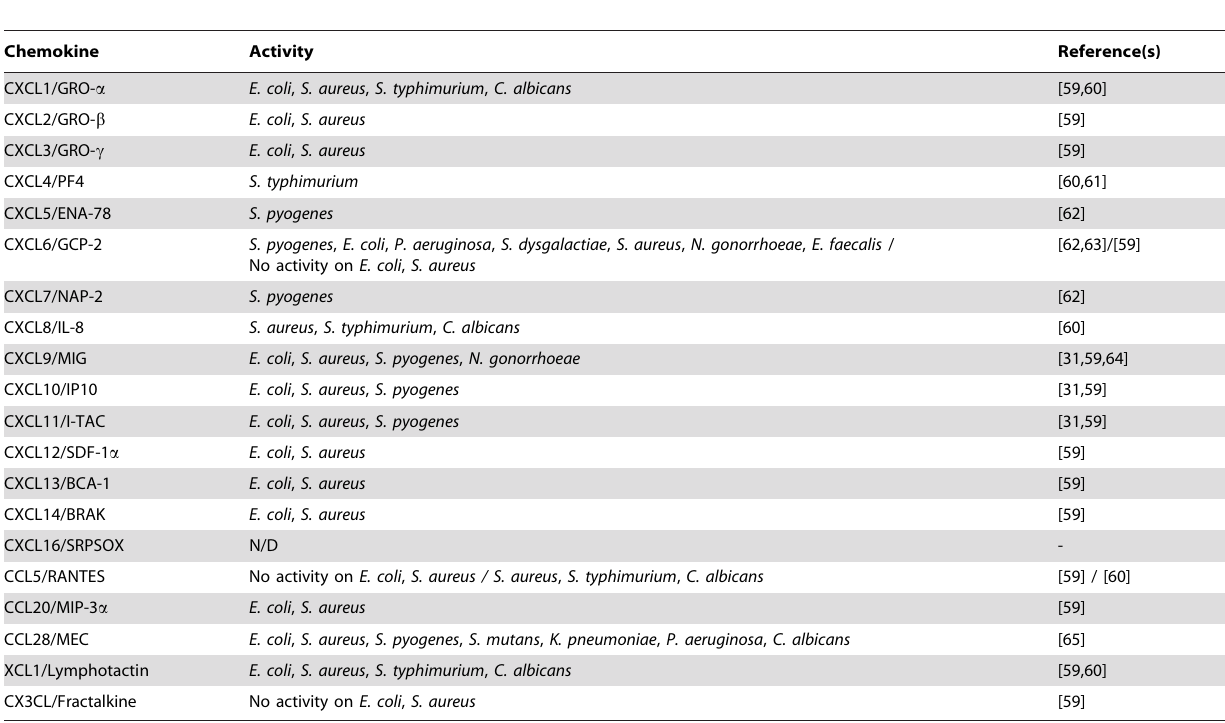
Table 1. Known antimicrobial activities of the chemokines used in the present study.